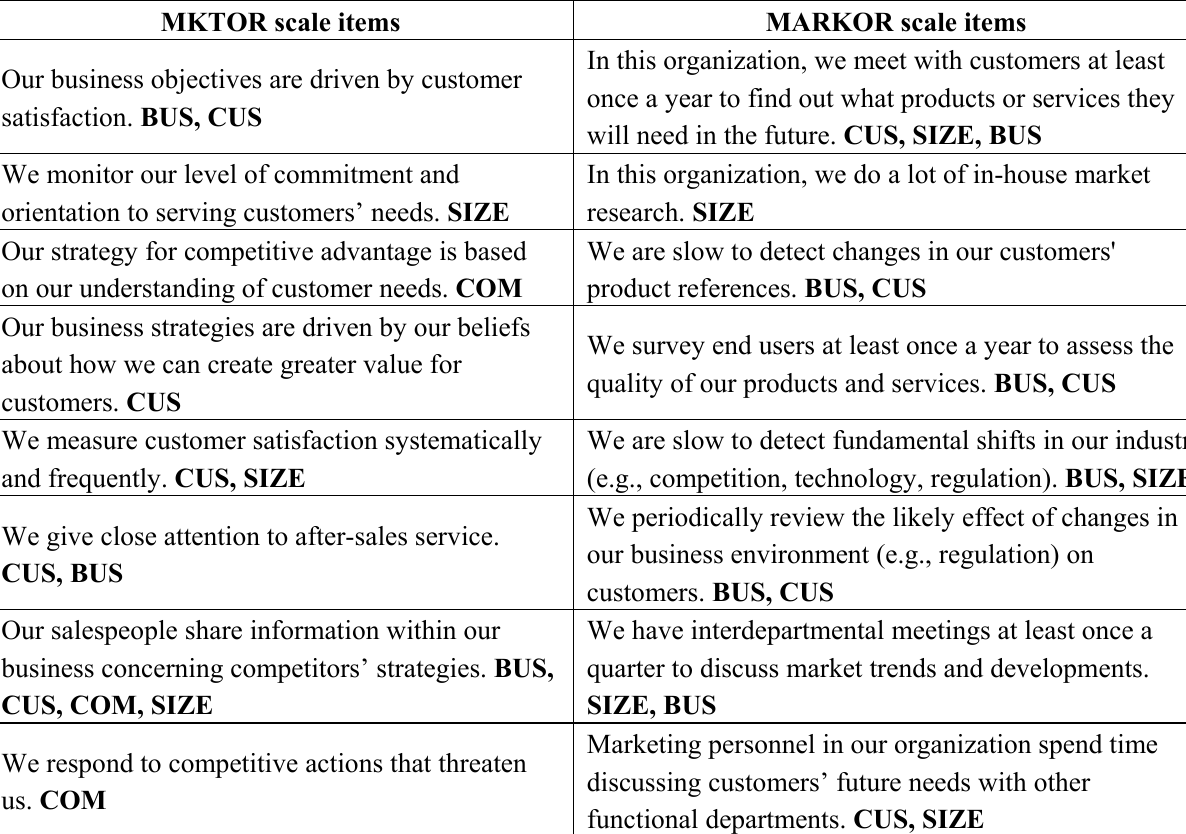
Table 2. Market orientation scale